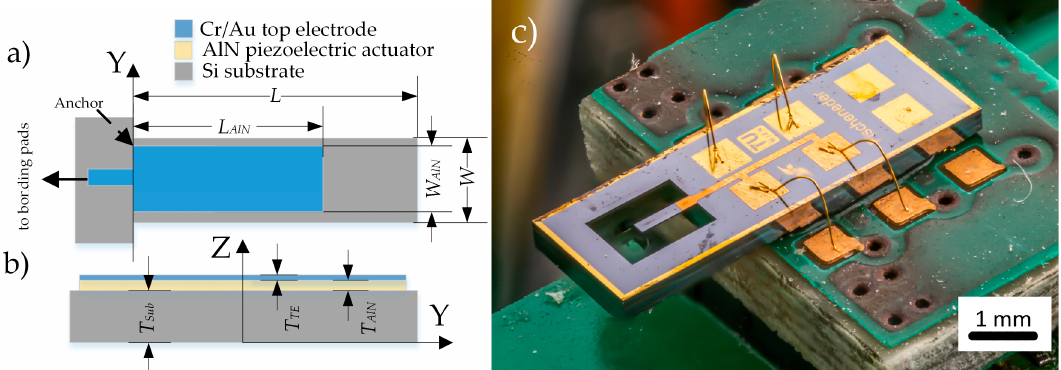
Figure 2. Schematics of the piezoelectric micro electro-mechanical systems (MEMS) cantilever. In ( a )